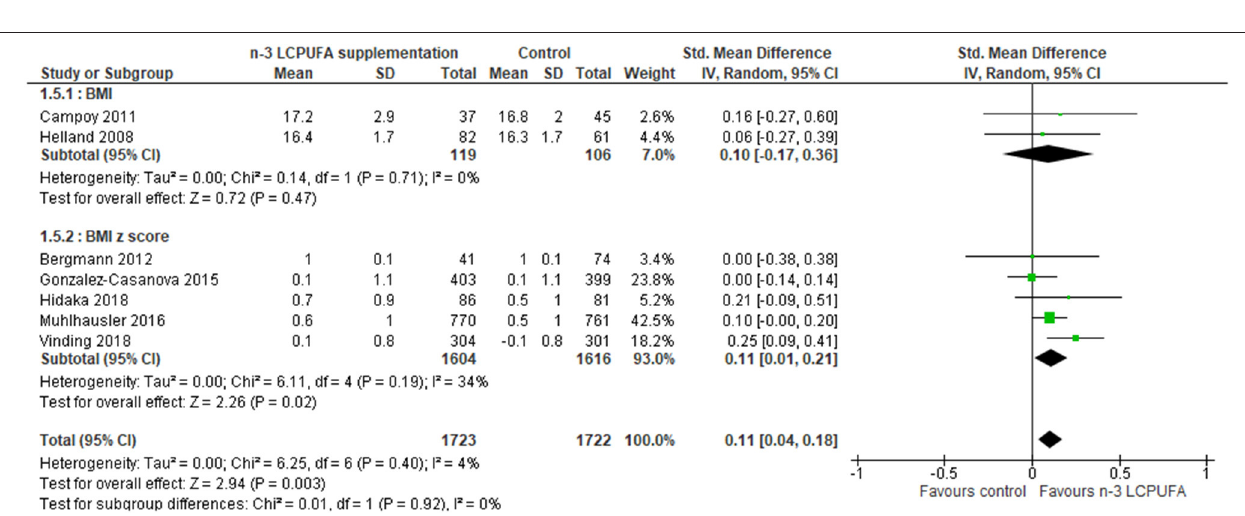
FIGURE 6 | Maternal n-3 LCPUFA supplementation in pregnancy and offspring BMI or BMI Z score at 5–10 years of